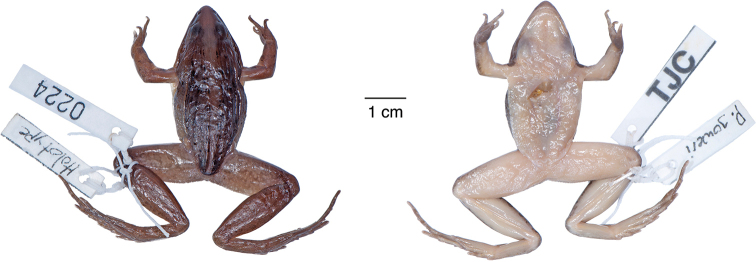
Holotype of Ptychadena
goweri. Dorsal and ventral views of the male holotype (TJC224).